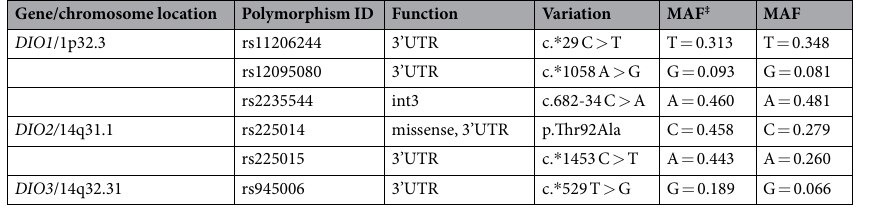
Table 1. General information about genotyped loci for DIO1, DIO2 and DIO3 polymorphisms. DIO – deiodinases, MAF ‡ – reported minor allele frequencies in single nucleotide polymorphisms databases